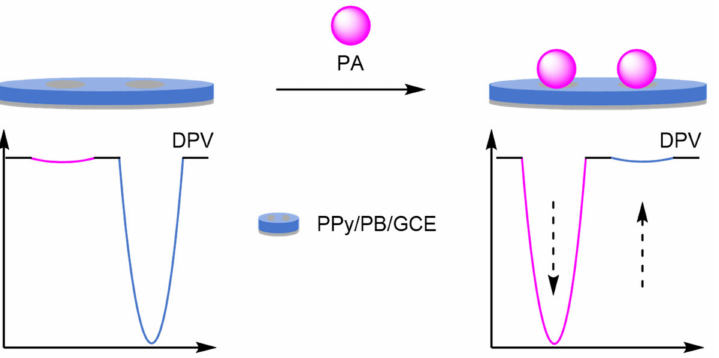
Figure 39. Schematic representation of a molecular imprinted polymer-based modified electrode for the detection of Paracetamol (PA).